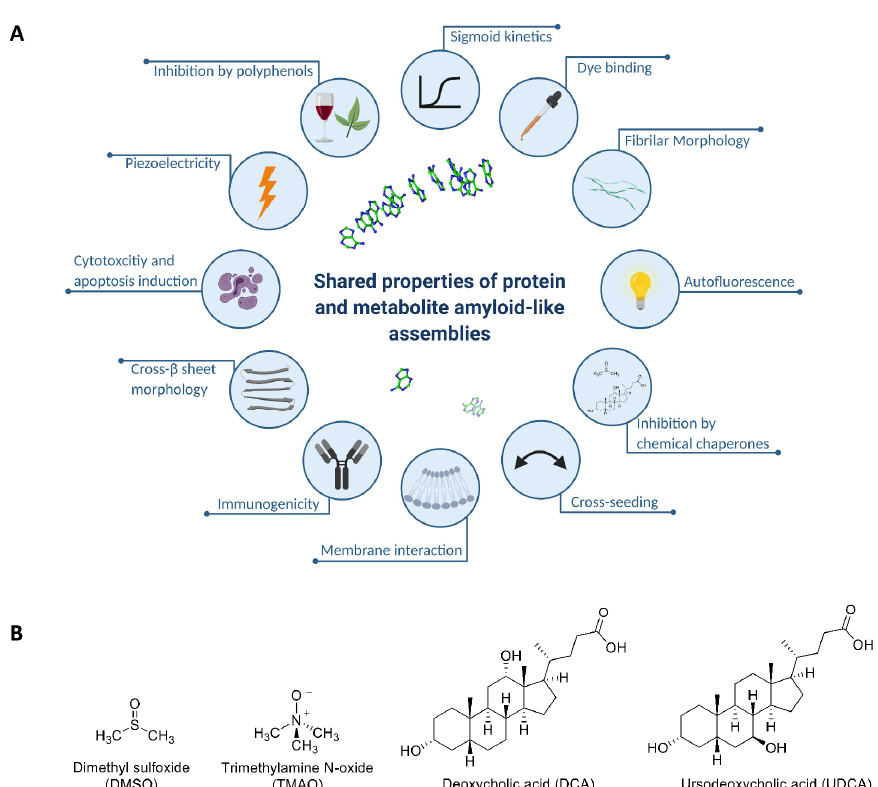
Figure 1. ( A ) Illustration of the shared properties of metabolite amyloid-like structures and protein or peptide amyloids: nanoscale fibrillar morphology [33–36], β -sheet secondary structure [37], amyloid-specific fluorescent dye binding [27,33,34], cytotoxicity and apoptosis induction [27,33–36,38,39], membrane interaction [40–44], inhibition by polyphenols [27,45], cross-seeding with protein amyloids [36,46], immunogenicity [27,33,36,47], intrinsic fluorescence [48,49], sigmoid growth curve [27], piezoelectricity [50], and inhibition by chemical chaperones (this study). Created with BioRender.com. ( B ) Molecular structure of DMSO, TMAO, DCA, and UDCA.